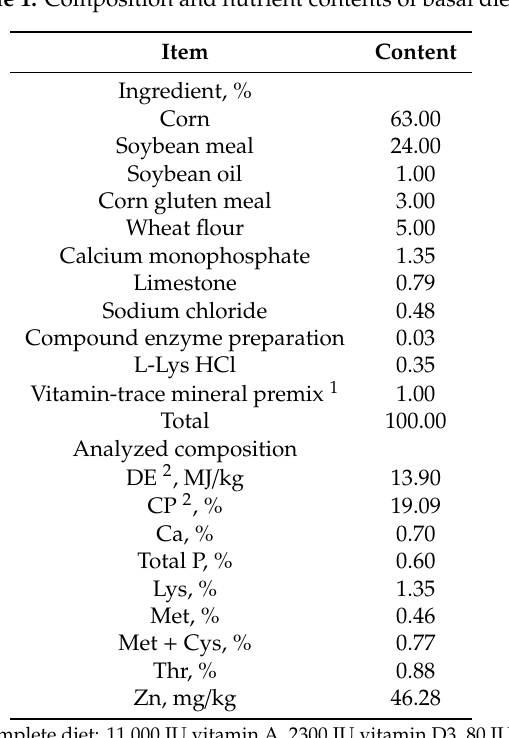
Table 1. Composition and nutrient contents of basal